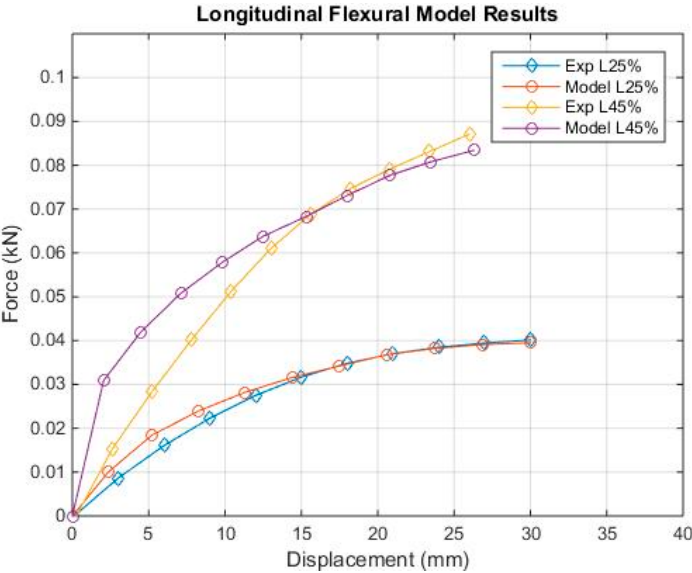
Figure 14. Three-point bending experimental and simulated stress–strain curves for the longitudinal direction.